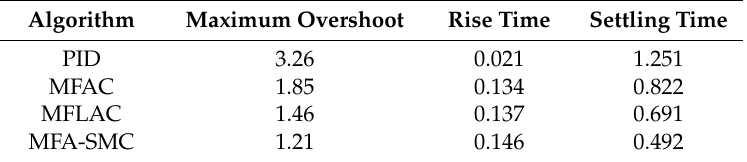
Figure 17. Comparison analysis of step response of the BLDC motor using PID, MFAC, MFLAC, and MFA-SMC. Table 2. Comparative analysis of all data-driven control